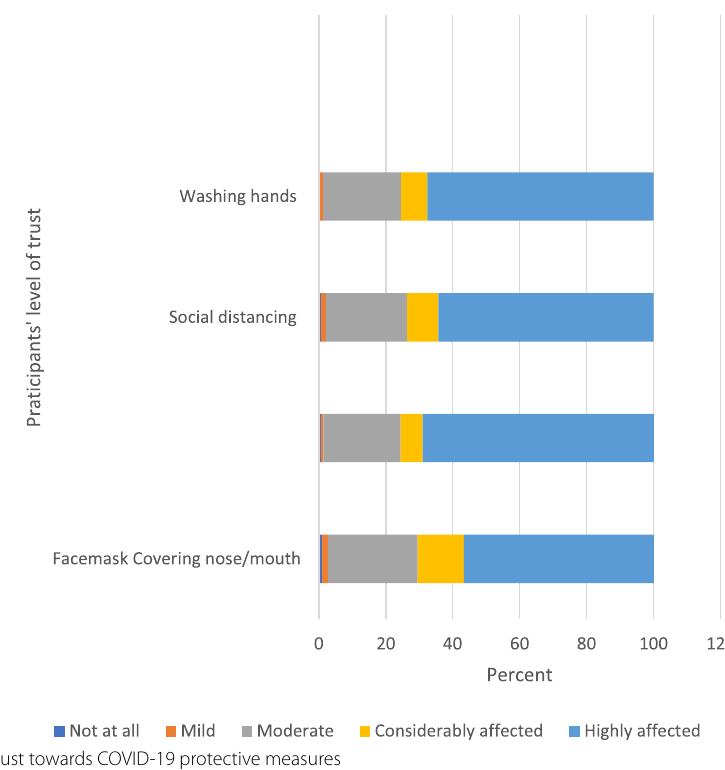
Fig. 2 Students’ level of trust towards COVID-19 protective